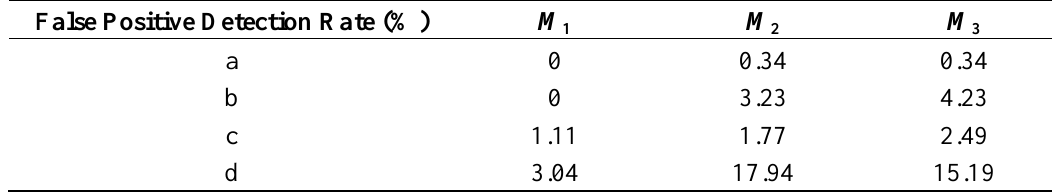
Table 3. Comparisons regarding the false positive detection